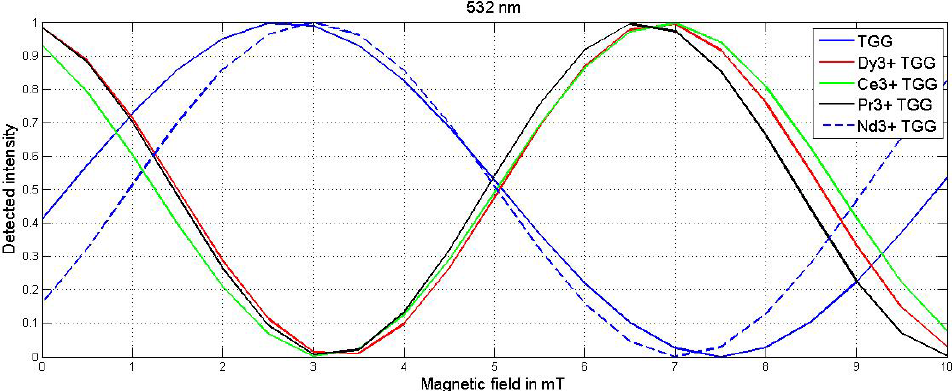
Figure 3. Variation of detected intensity ( I out ) with magnetic field (mT) at the 532nm wavelength of TGG, Dy 3 + doped TGG, Ce 3 + doped TGG, Pr 3 + doped TGG and Nd 3 + doped TGG for analyzer angles 48, 47, 50, 47 and 42 ◦ , respectively (Table 3).